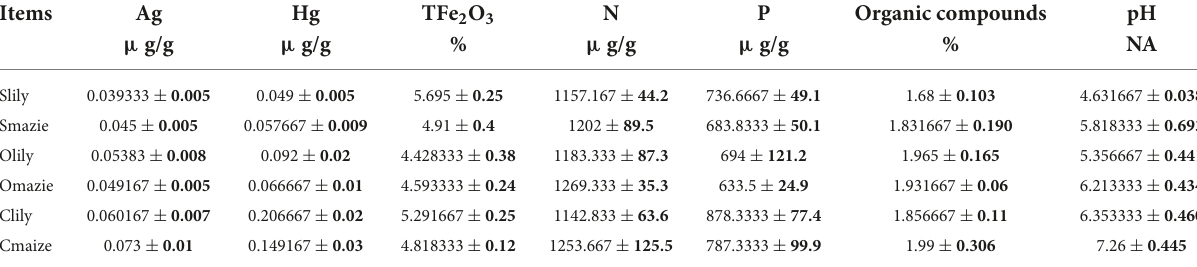
TABLE 1 Statistical table of soil characteristics, including chemical elements and organic matter, in XiangXi perfecture. Items Ag Hg Organic compounds